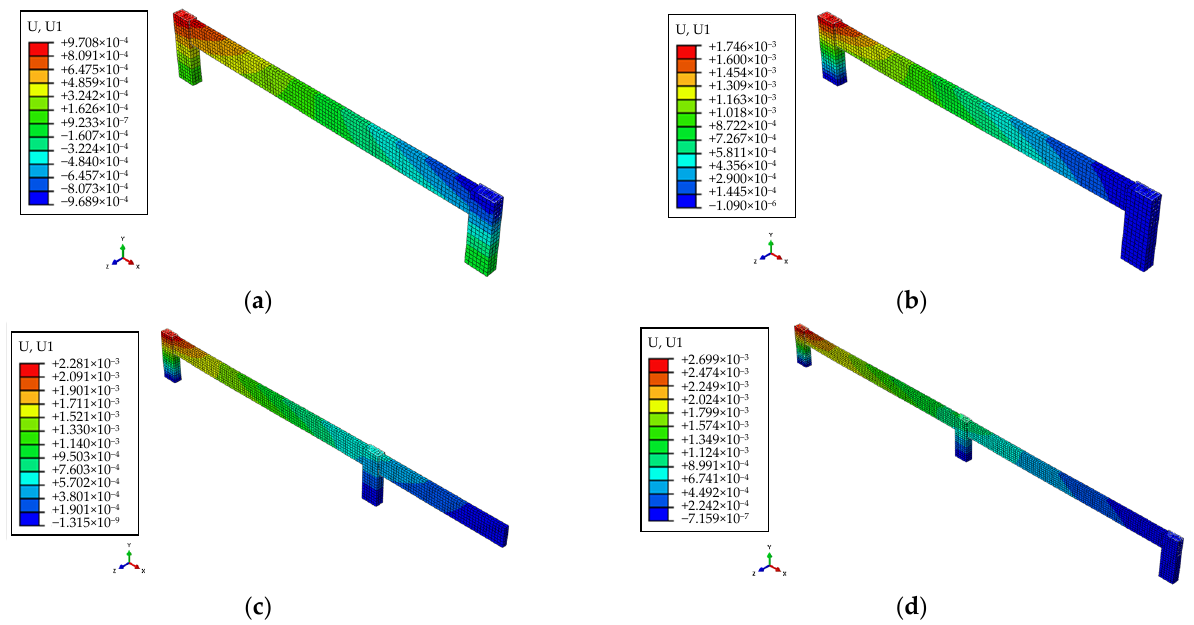
Figure 7. Capital level displacements of side columns in multi-span prestressed frame struc- tures(unite:m). ( a ) YKJ2 model. ( b ) YKJ8 model. ( c ) YKJ9 model. ( d ) YKJ10 model.